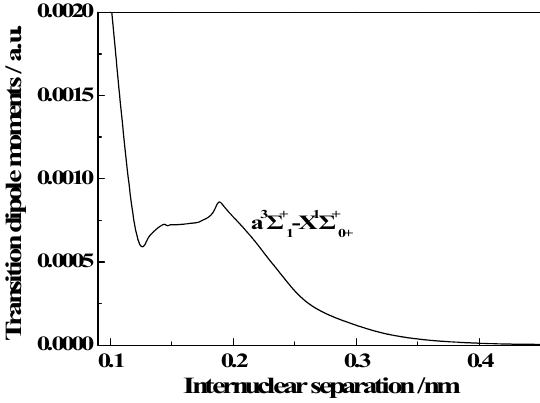
Figure 3. TDMs versus internuclear separations of transitions from the a 3 Σ +1 state to the X 1 Σ +0+ state.